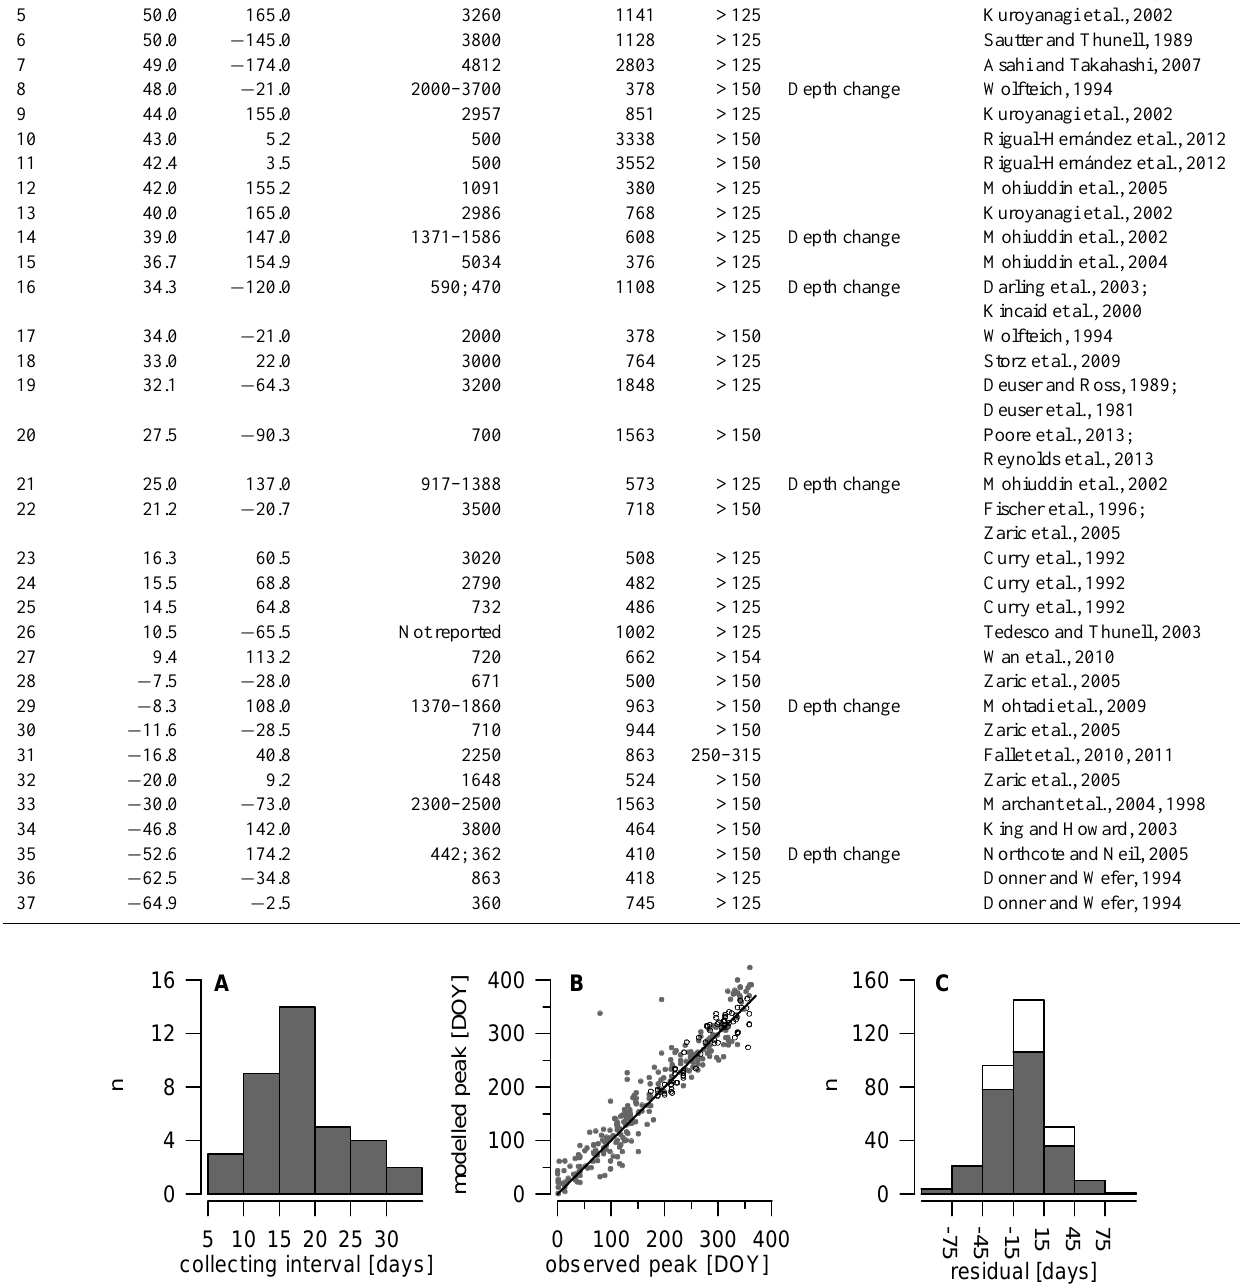
Figure 2. Histogram of average collecting interval for all time series (a) . Observed vs. modelled peak time (b) and residual of observed − modelled peak time (c) . See Figs. S3 and S4 for individual species. Solid symbols in (b) and grey shading in (c) denote sin- gle or first cycles and open symbols second cycles in panel (c)